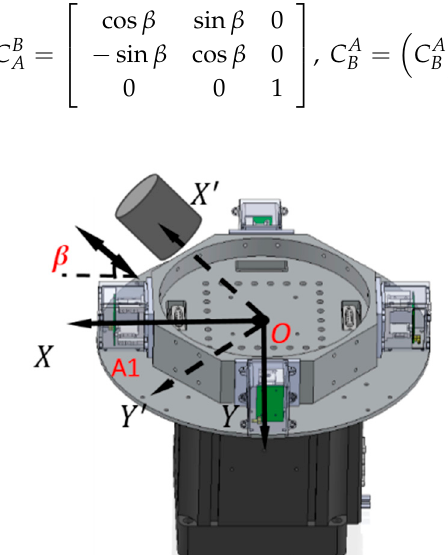
Figure 2. Schematic diagram of the calibration experiments.